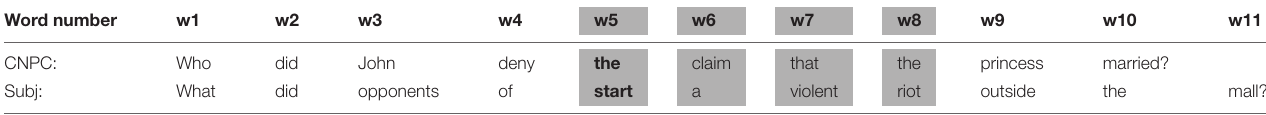
TABLE 2 | Sample Complex-NP Constraint (CNPC) and Subject island sentences with corresponding word numbers. Shaded region denotes region of interest.